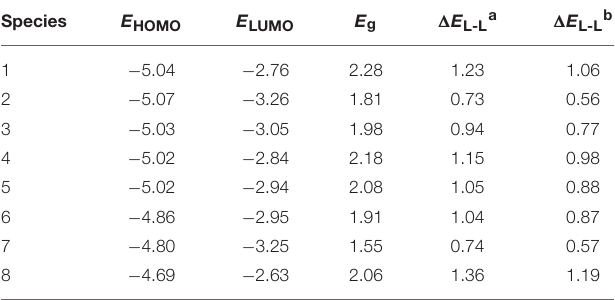
TABLE 2 | Calculated E HOMO , E LUMO , E g , and 1 E L − L (all in eV) for investigated molecules at the PBE0/6-31G(d,p). Species